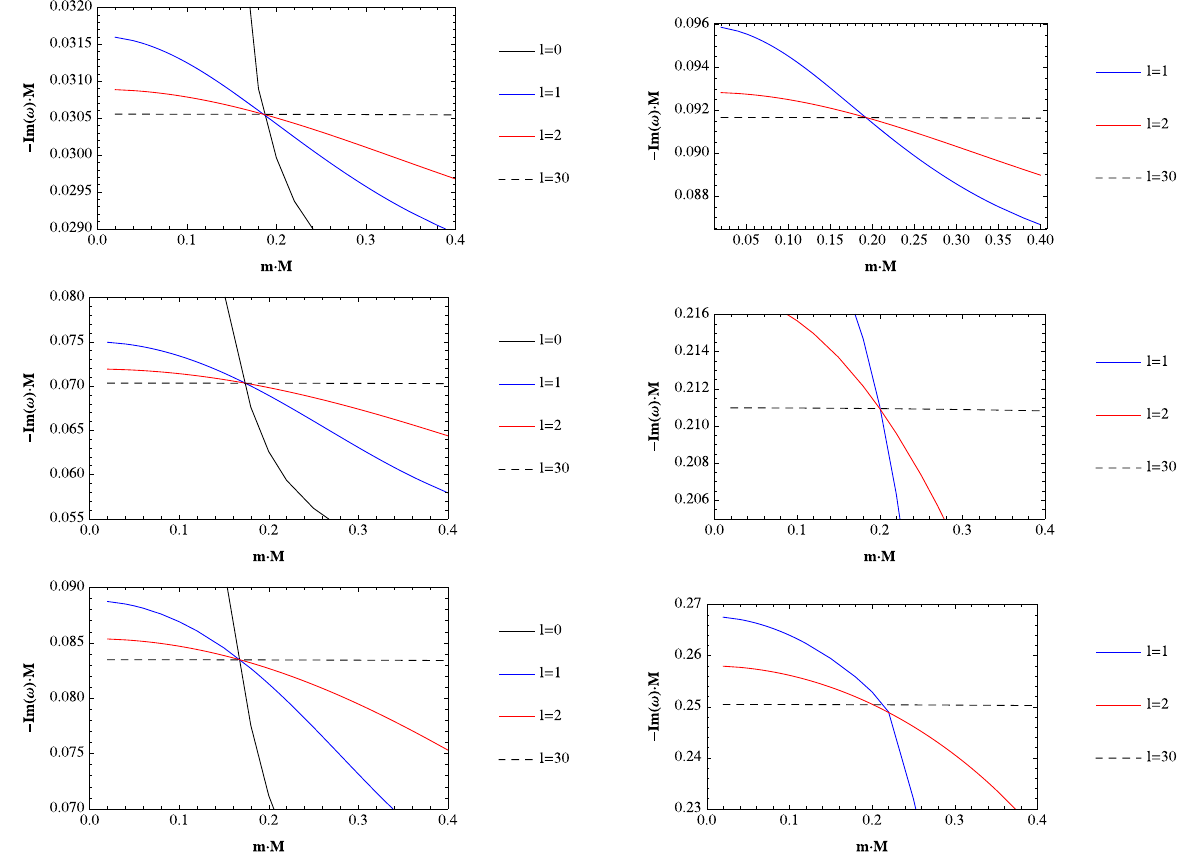
Fig. 4 The behavior of − Im (ω) M as a function of the scalar field mass for different values of the parameter (cid:5) = 0 , 1 , 2 , 30 and n PS = 0 (left panels), and (cid:5) = 1 , 2 , 30 and n PS = 1 (right panels) with M 2 (cid:6) = 0 . 04, and from top to bottom M β = − 0 . 06 , − 0 . 01, and 0 . 01,